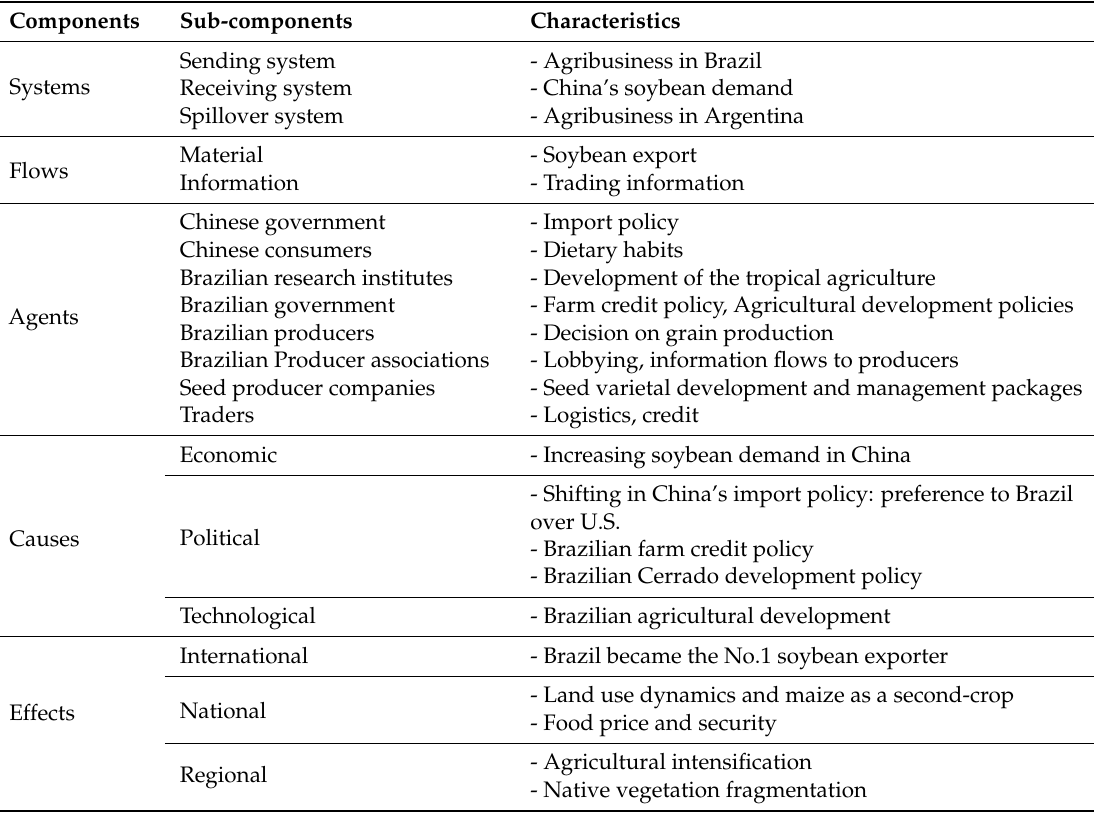
Table 1. The five components of the Brazil and China telecoupled soybean system.